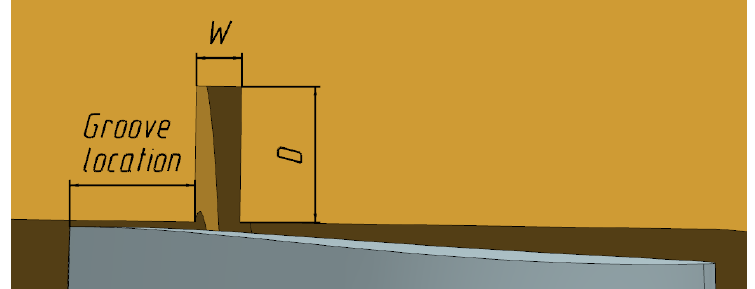
Figure 1. Baseline Geometry.